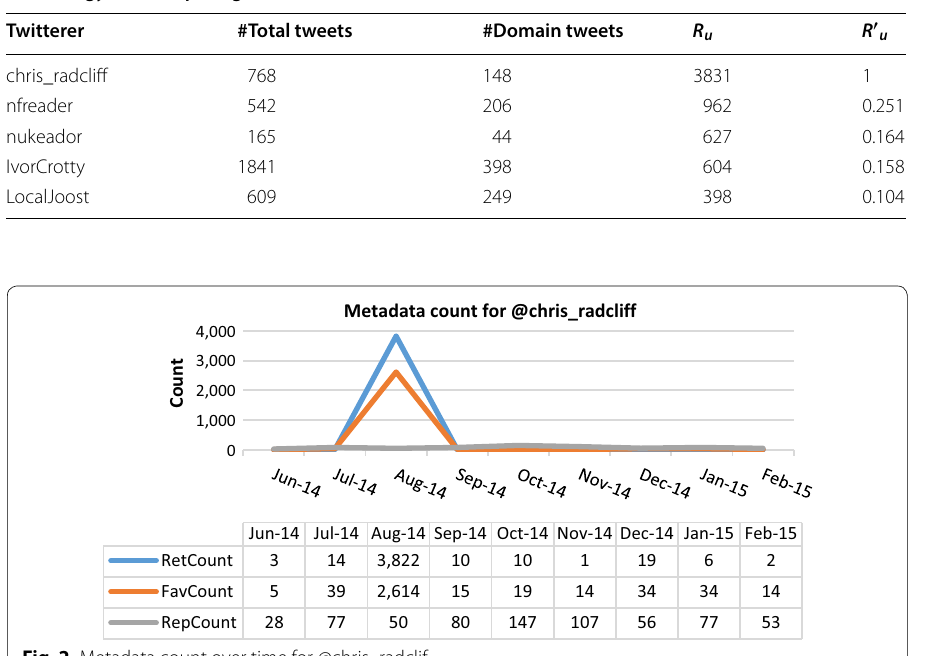
Fig. 2 Metadata count over time for